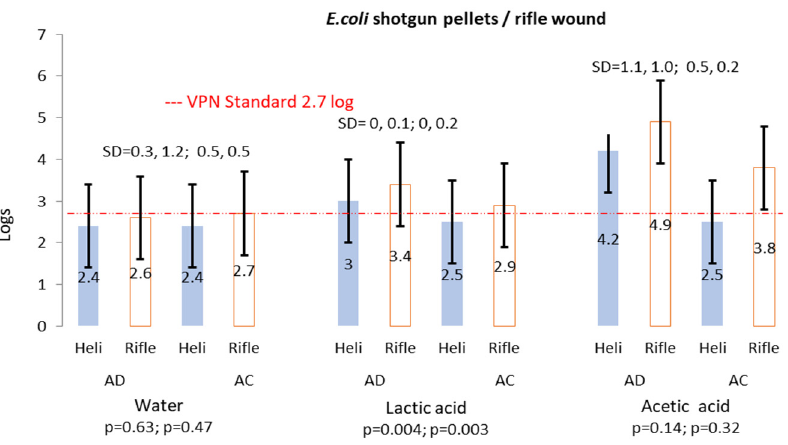
Figure 4. Average log counts of E. coli helicopter and rifle wounds before and after water, LA and AA treatment.